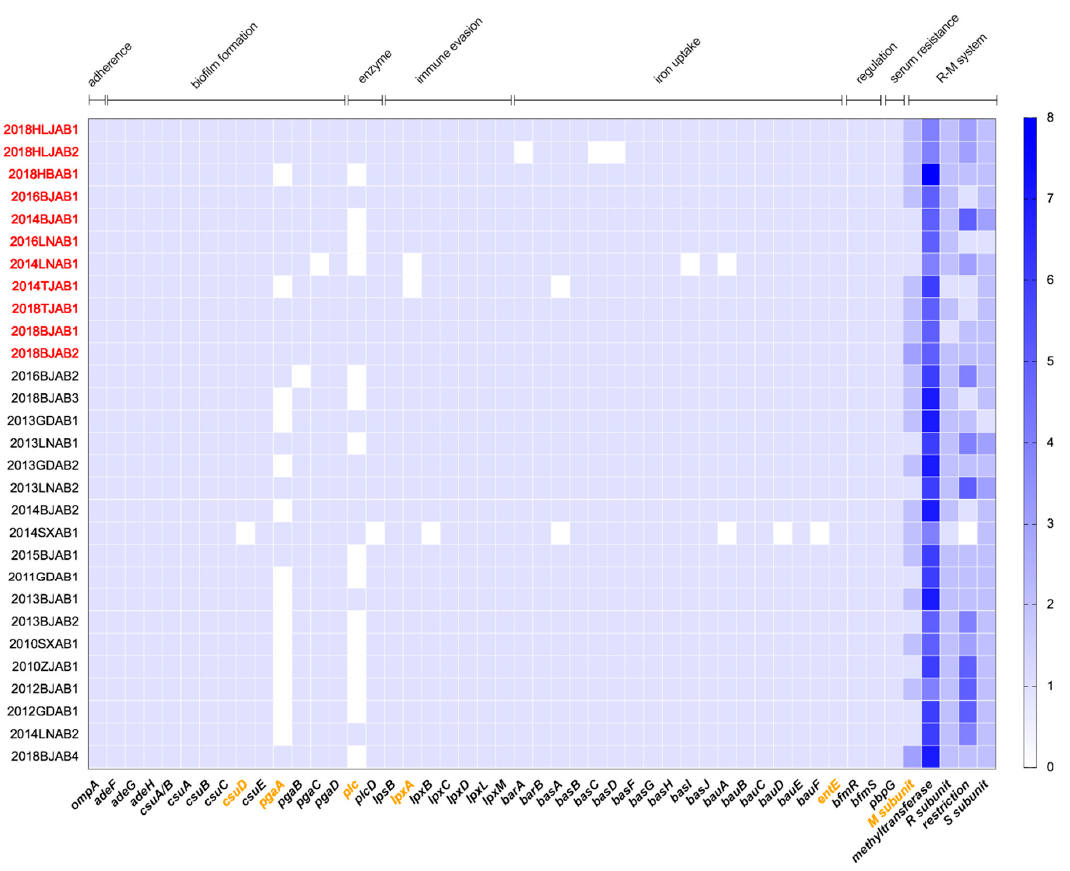
Figure 4. Distribution of virulence and R-M system-related genes in CO and SI isolates. The blue color shade indicated gene presence. The red marked isolates represented CO isolates and the orange marked genes represented differential genes between CO and SI. Virulence gene types were labeled in the upper part.